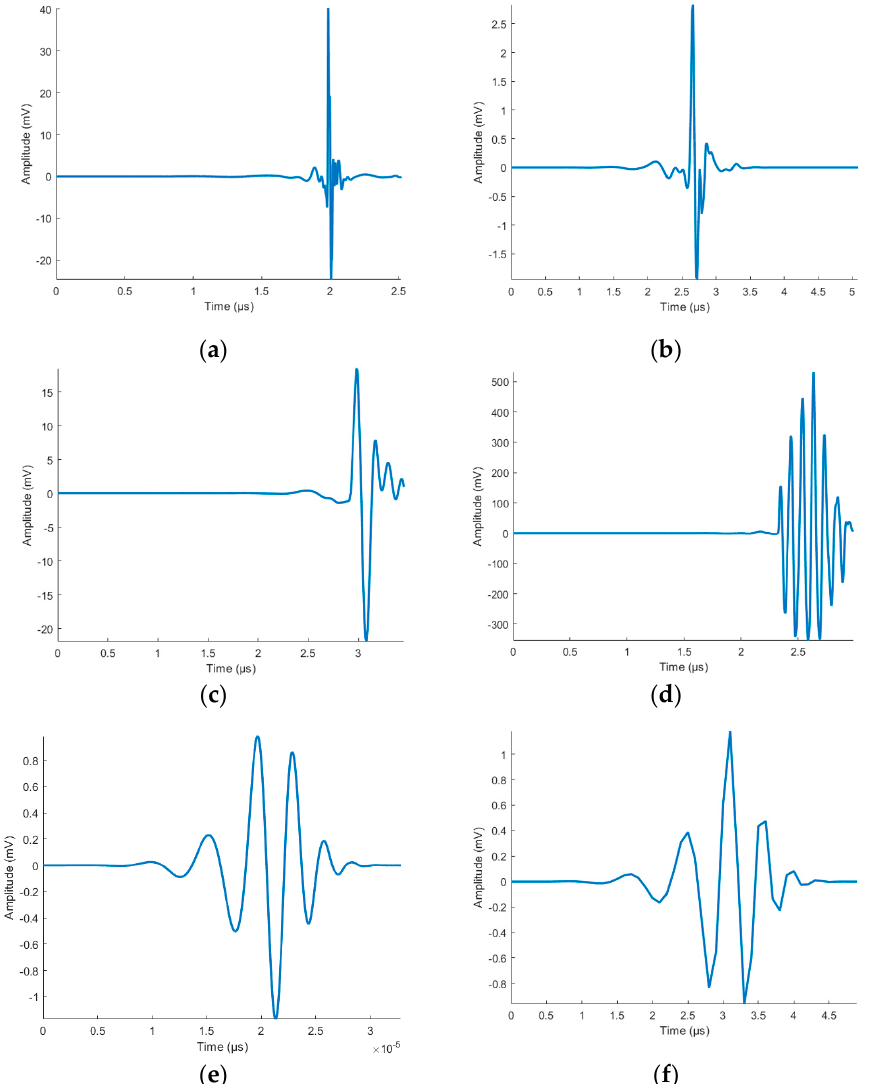
Figure 9. Representative pulses of each signal source measured: corona ( a ); internal PD ( b ); surface PD ( c ); IGBT pulses ( d ); random noise ( e ); and electronic noise ( f ).